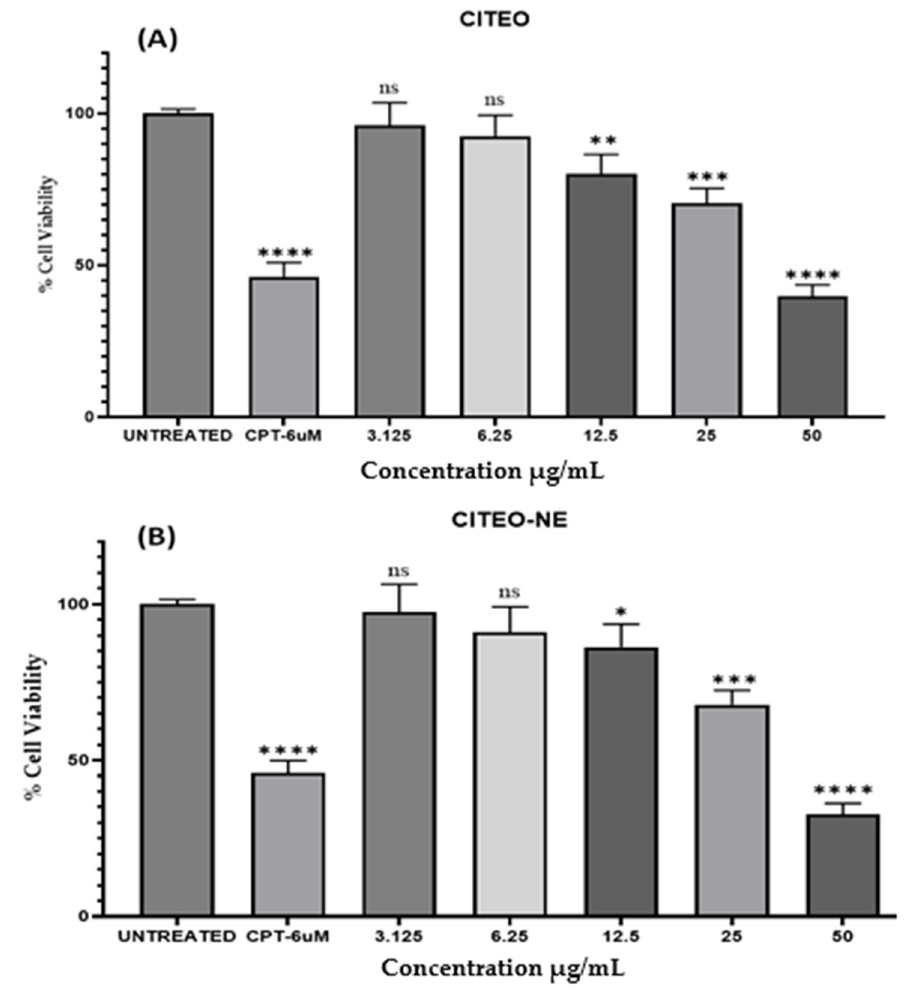
Figure 5. Cytotoxicity assay of CITEO ( A ) and CITEO ‐ NE ( B ) with different concentrations against A431. p ‐ value (* p < 0.05, ** p < 0.01, *** p < 0.001 and **** p < 0.0001; ns: not significant) when compared to the untreated group using two ‐ way ANOVA of GraphPad prism 9.5.0.